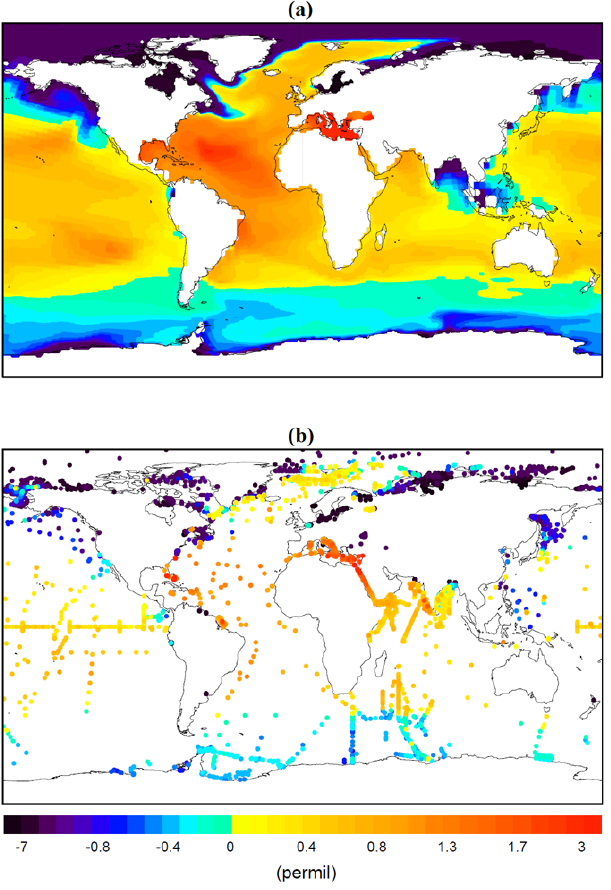
Fig. 2. (a) The annual mean δ 18 O distribution in ocean surface waters as simulated by MPI-OM. (b) The sea surface δ 18 O mea- surements included in the Global Seawater Oxygen-18 Database (Schmidt et al., 1999).